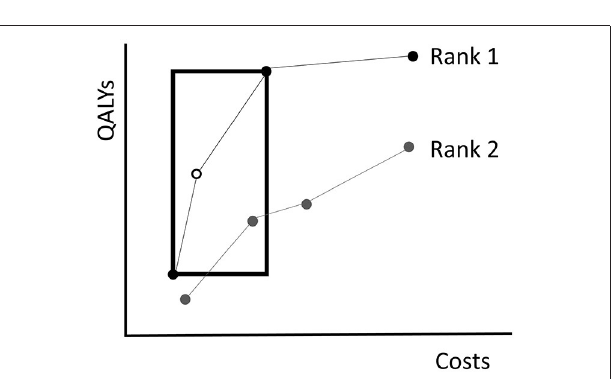
FIGURE 4 | An illustration of the NSGA-II algorithm. The dots represent the costs of and QALYs gained by several fictive policies. Policies with equal rank are connected by the lines. Non-dominated policies obtain rank 1. Those that are dominated by policies with rank 1 only, obtain rank 2, etc. The crowding distance of the white policy equals the circumference of the rectangle drawn around it. The rectangle touches the next less costly and next more expensive policies with equal